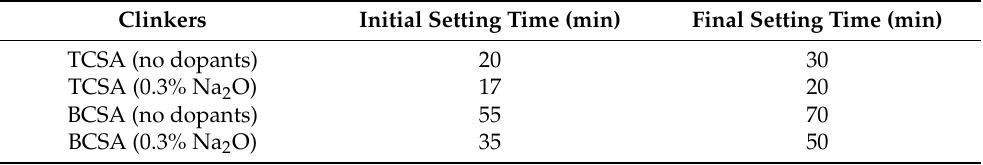
Table 9. Setting time of TCSA and BCSA cement